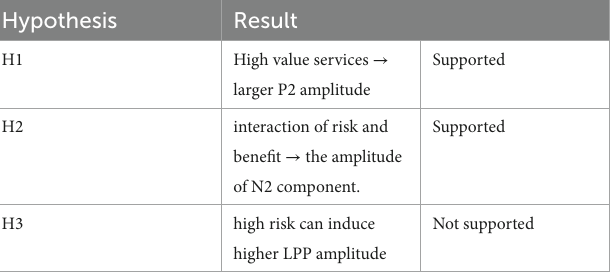
TABLE 6 Summary of hypotheses